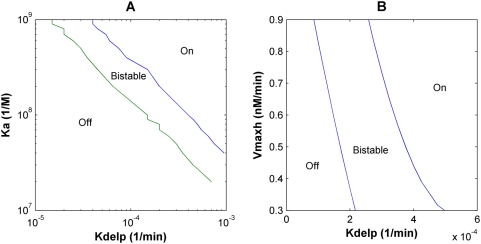
Bifurcation Analysis.(A) Bifurcation analysis of how the switching points vary with the equilibrium binding constant (Ka) of NICD to RBP-Jk. Stronger interaction between NICD and RBP-Jk lowers the threshold of Delta signal required to turn the system ON. (B) Bifurcation analysis of how the switching points vary with the maximal transcription rate of Hes1 (Vmaxh). A higher maximal transcription rate, indicating a stronger Hes1 promoter, also slightly shifts the region of bistability towards lower Delta signal strengths.